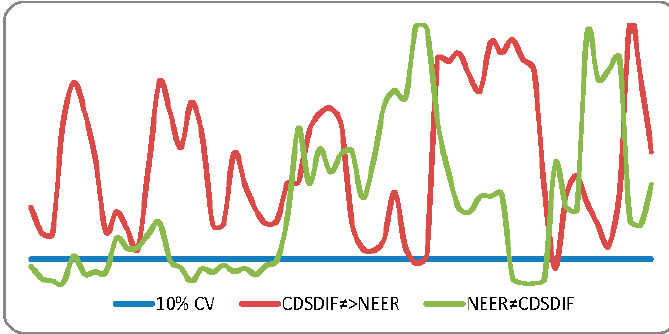
Figure 3. Balcilar et al. [26] bootstrap rolling window causality results.